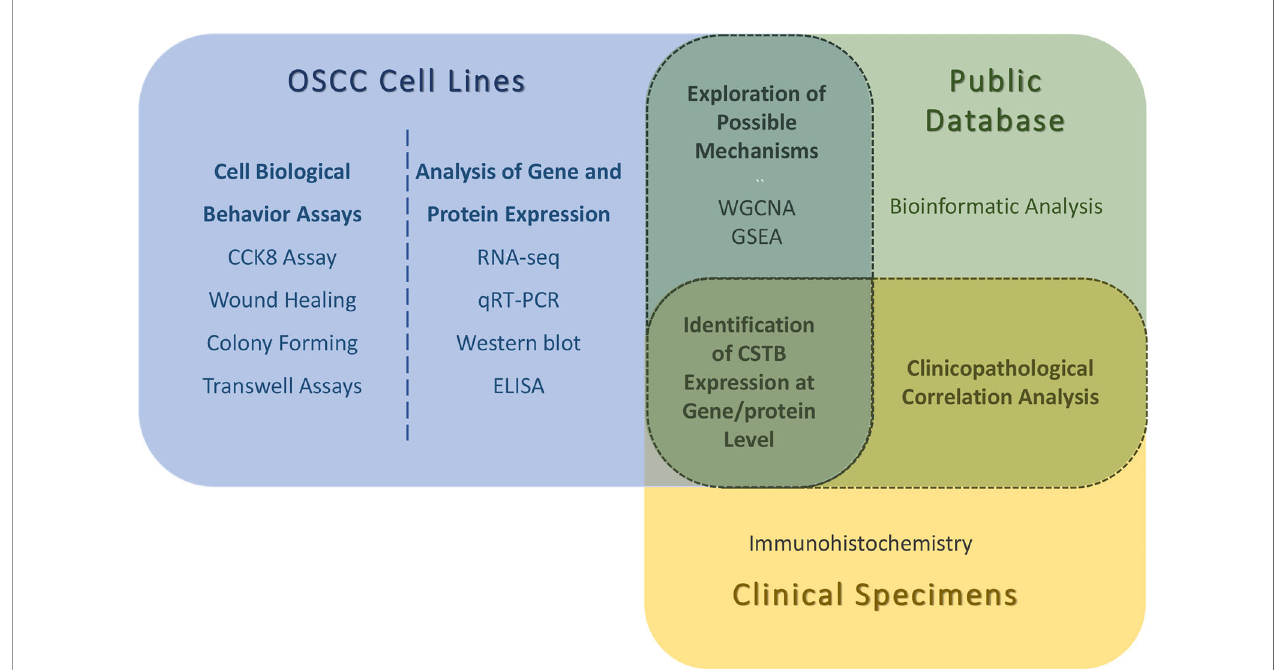
FIGURE 1 | Snapshot of the entire experimental process. WGCNA, weighted gene correlation network analysis; GSEA, gene set enrichment analysis. The identi fi cations of CSTB expression at gene/protein levels are obtained by in vitro (OSCC cell lines) and in vivo (public database/clinical specimens) experiments. Possible mechanisms for the involvement of CSTB in OSCC were explored using OSCC cell lines and public database data together. Using OSCC tissue samples (from public databases and independent clinical specimens) for clinicopathological correlation